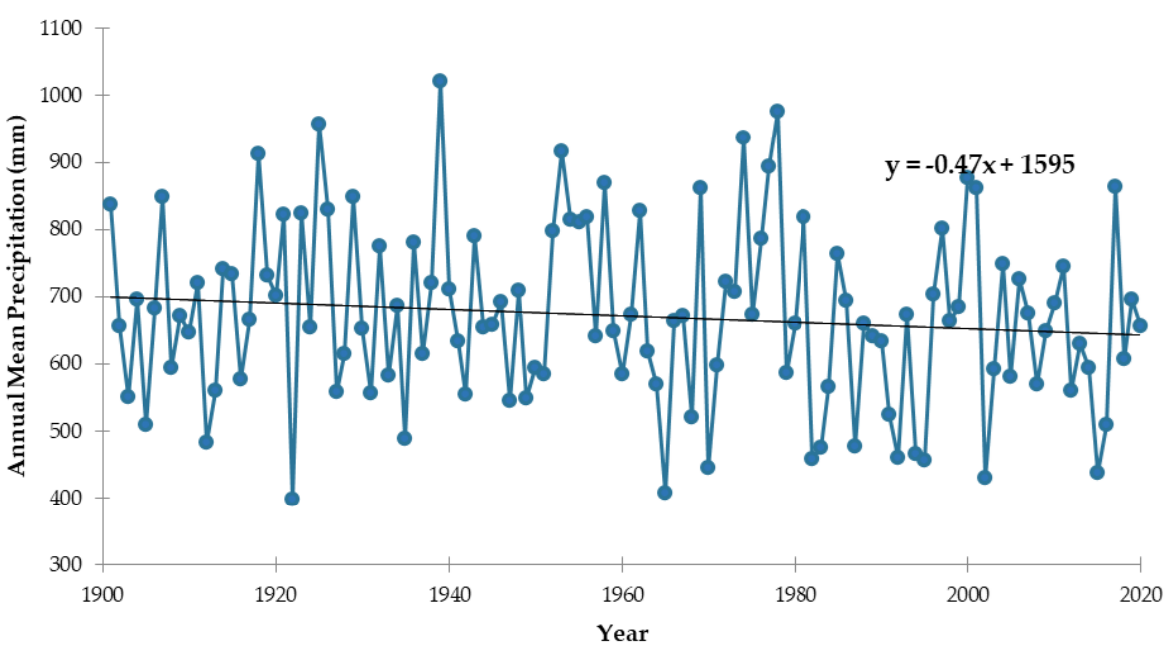
Figure 3. Rainfall trend in Zimbabwe from 1901 to 2020.